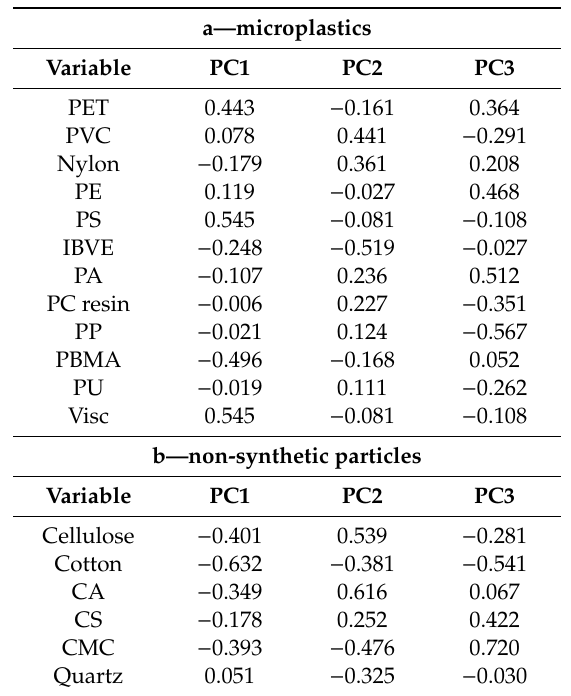
Table 3. Eigenvectors (Coe ffi cients in the linear combinations of variables making up PC’s for the first three axes) describing the fraction of total variance explained by each PCs associated to the PCA reported in Figure